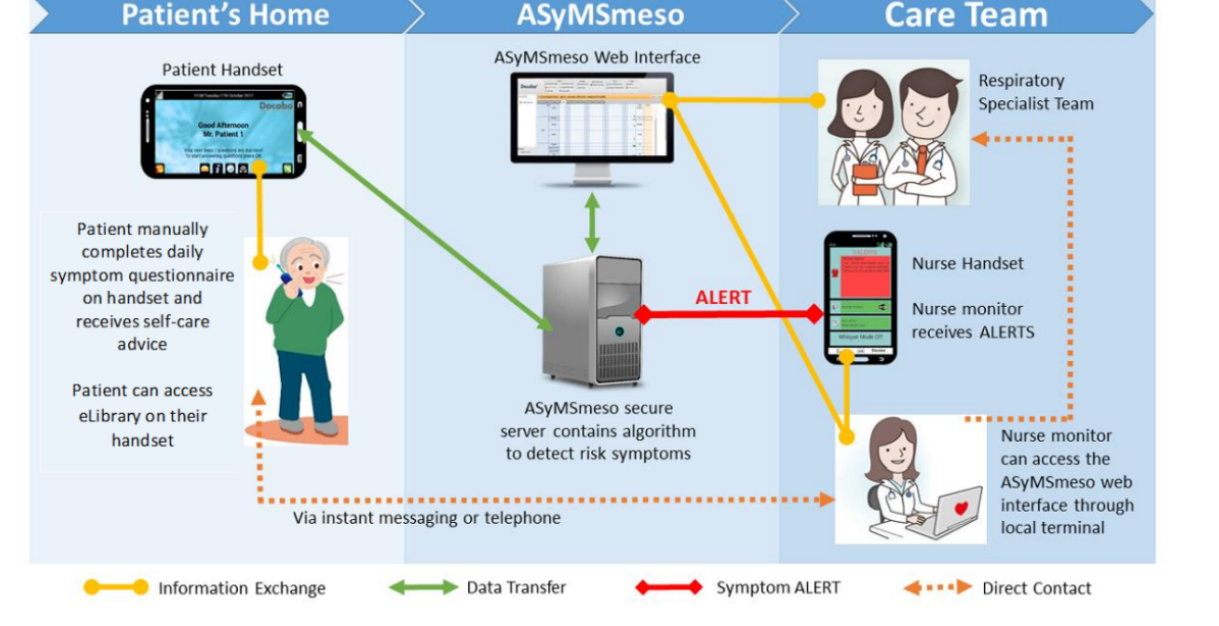
Figure 1. The Advanced Symptom Management System for patients with malignant pleural mesothelioma (ASyMSmeso) intervention